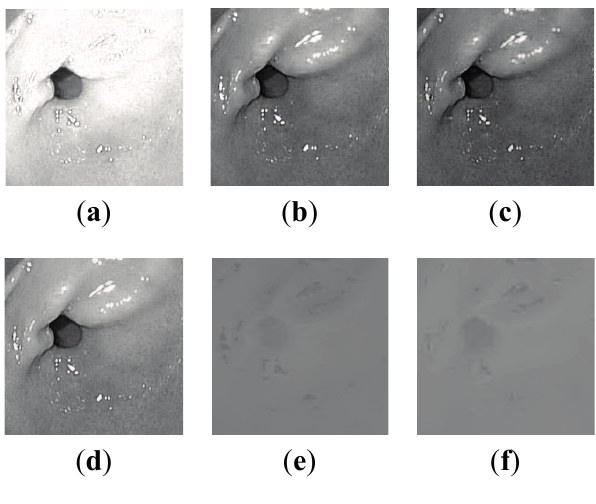
Figure 4. Intensity distribution of color components of a WLI image: ( a ) R, entropy: 6.15; ( b ) G, entropy: 6.74; ( c ) B, entropy: 6.53; ( d ) Y, entropy: 6.65; ( e ) E, entropy: 3.44; ( f ) F, entropy: 3.26.